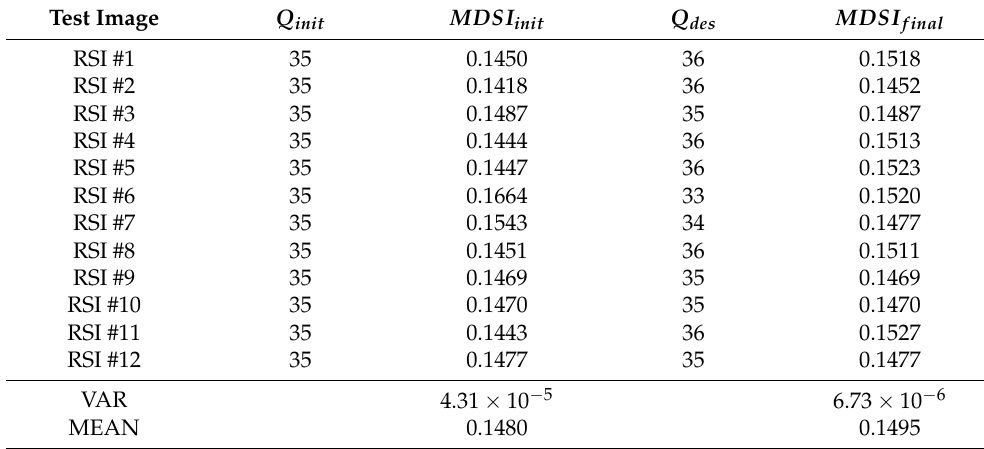
Table A4. The experimental data obtained for the basic image set for the desired MDSI =